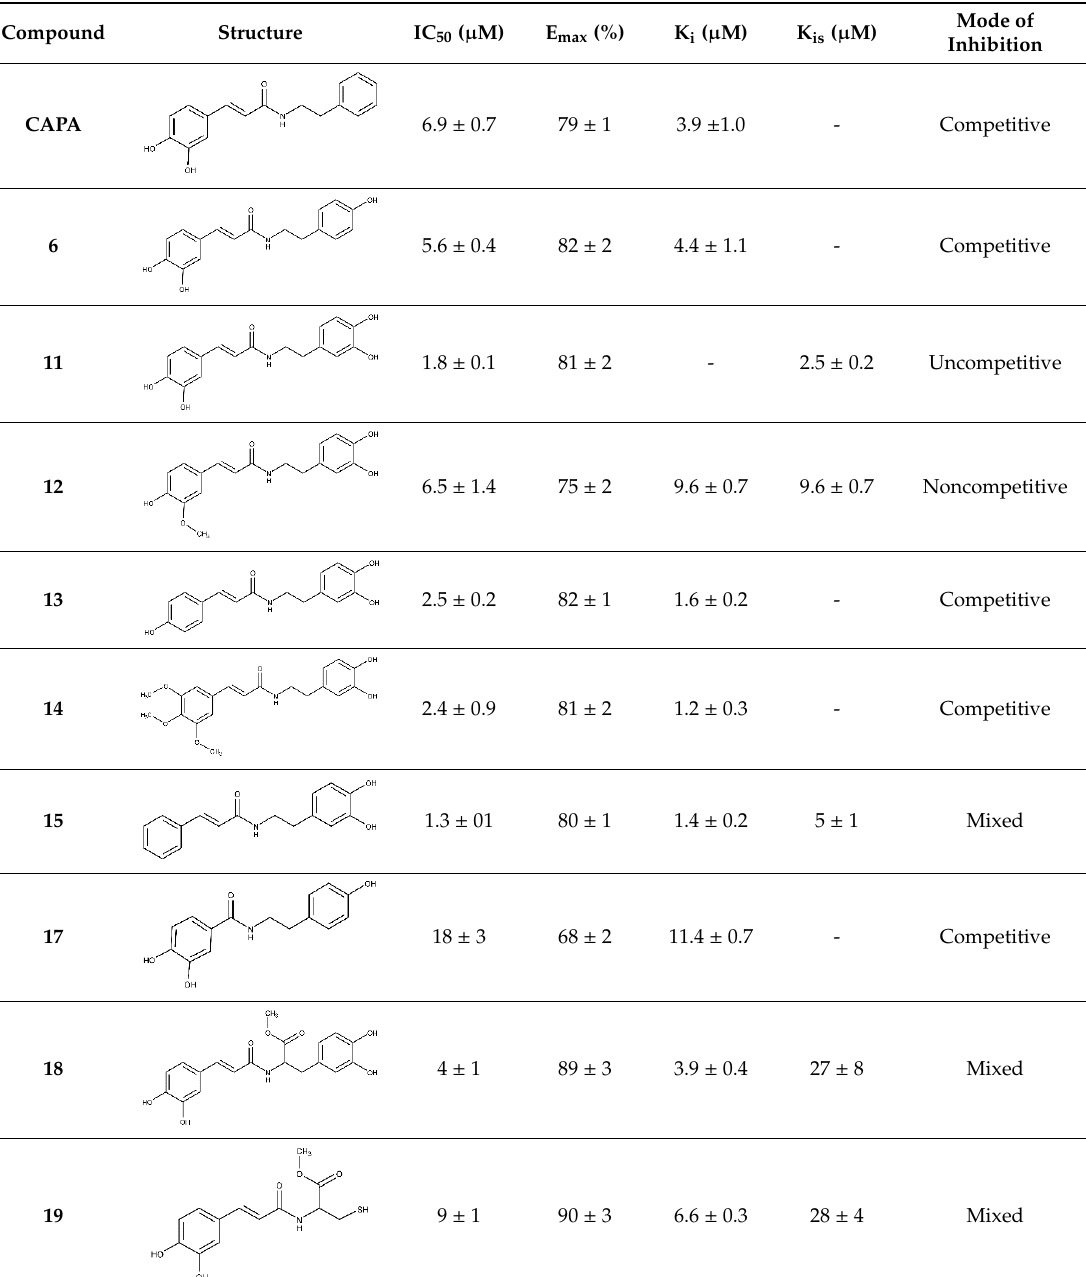
Table 1. Arginase inhibition by cinnamide compounds. IC 50, E max , dissociation constant, and mechanism of inhibition.